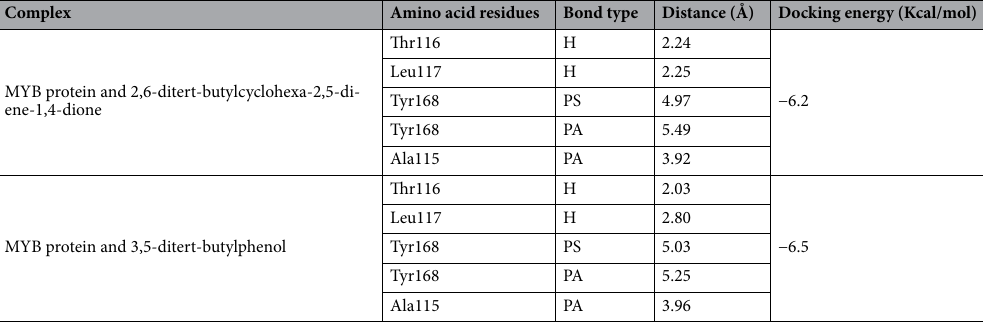
Table 1. The docking interactions of MYB gene and the top two ligand molecules in molecular docking. The interactions were found using Discovery Studio software, where A, PA, PS H, indicate the alkyl, pi-alkyl, pi-sulfur, and hydrogen bond,